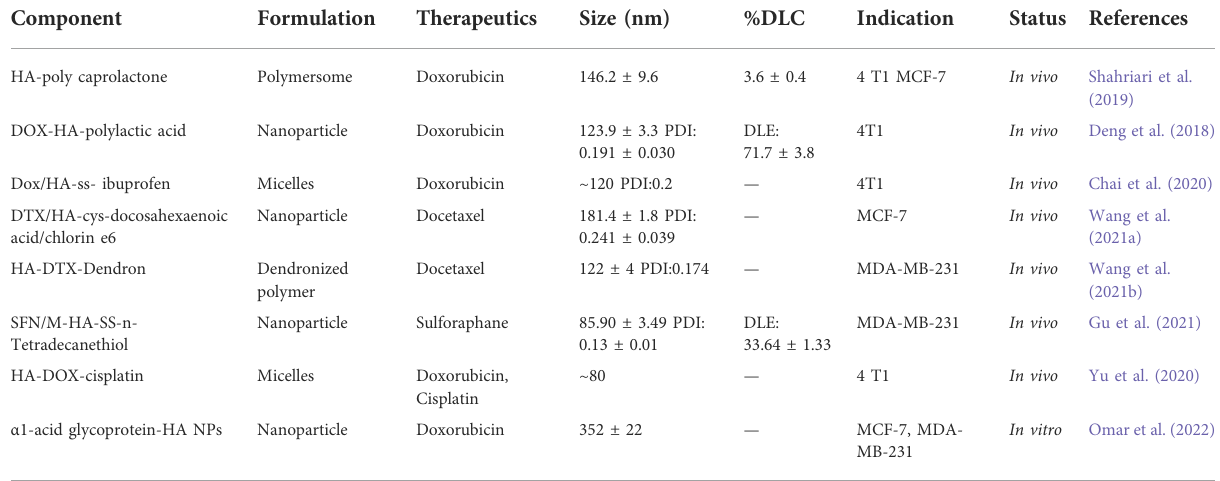
TABLE 2 Characteristics of modi fi ed HA